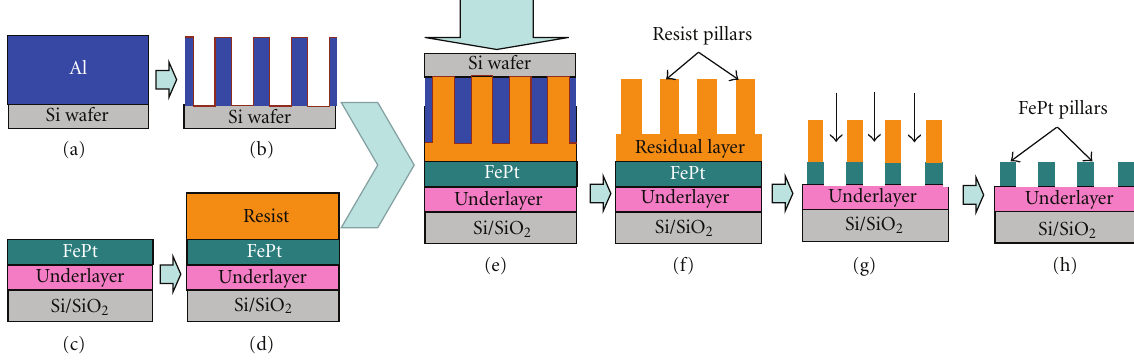
Figure 1: Schematic drawing of the fabrication of FePt patterned structure by using anodized alumina (AAO) mold. (a) Deposition of Al film on a Si wafer, (b) fabrication of AAO and coating it with thin SiO 2 and SAM layer, (c) fabrication of L1 0 ordered FePt thin film, (d) spin coating of the resist on FePt thin film, (e) nanoimprinting, (f) demolding, (g) removal of the residual layer by reactive ion etching (RIE) and transfer of the pattern into FePt film by Ar ion milling, and (h) removal of the resist to leave the FePt pillars on the substrate.